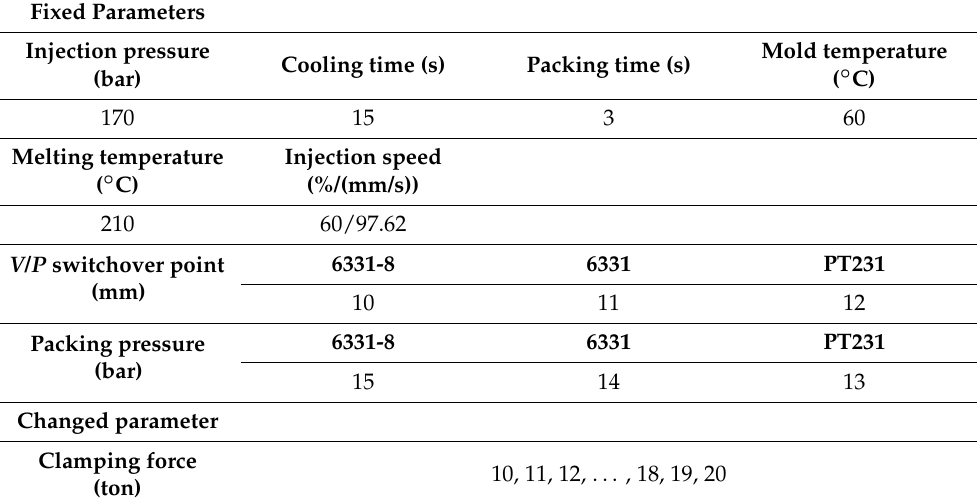
Table 5. Clamping force experiment